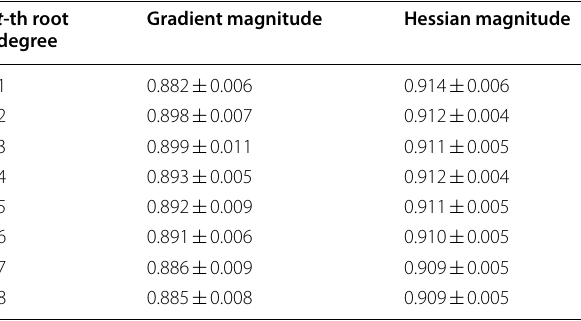
Table 2 AUC scores of gradient magnitude and Hessian magnitude under different t -th root mappings